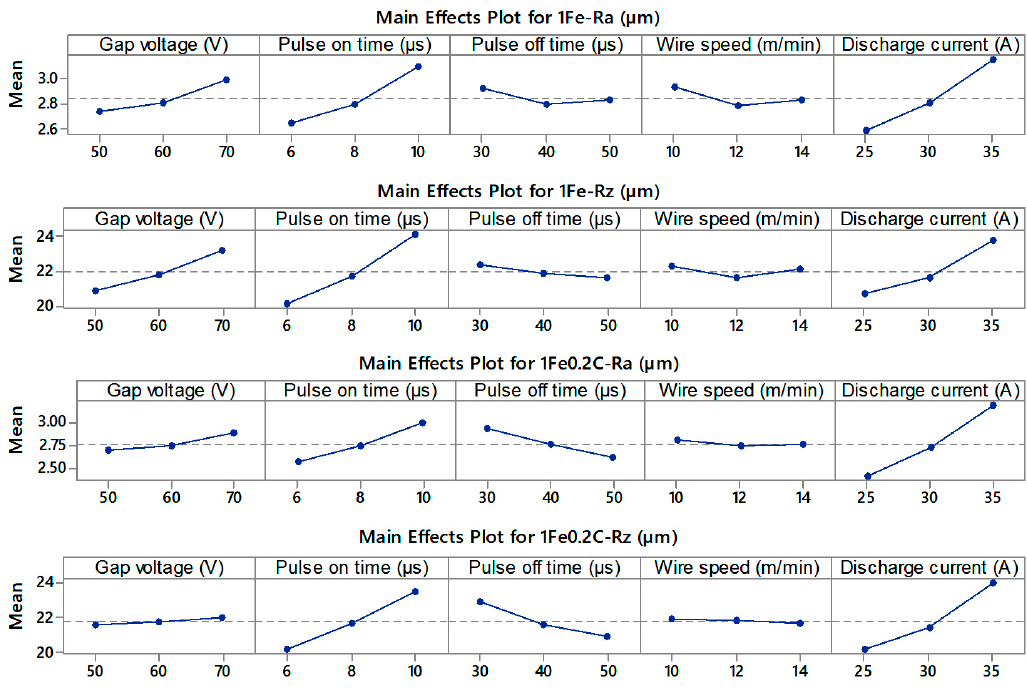
Figure 5. Main e ff ect plot of Ra and Rz for both